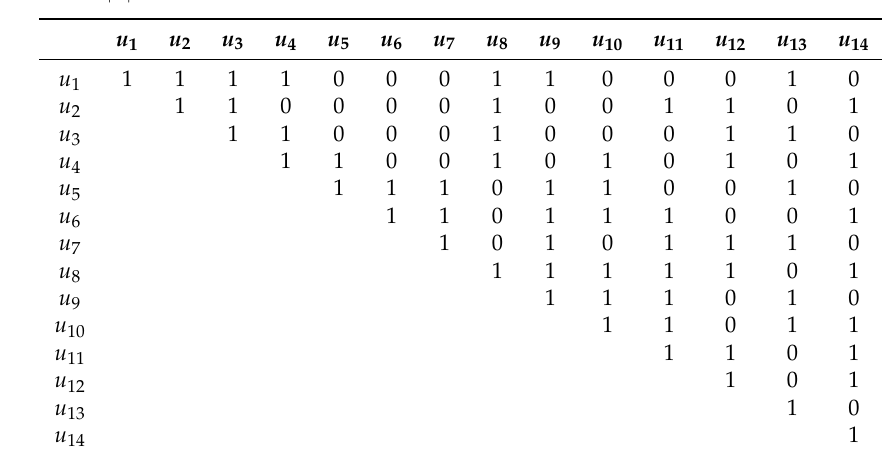
Table 2. Triangular indiscernibility matrix for standard granulation ( i < j ), derived from Table